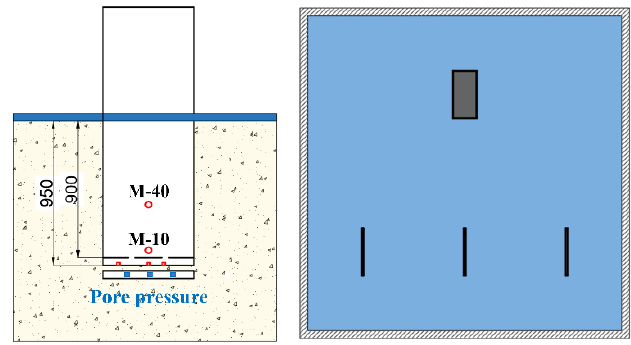
Figure 7. Schematic diagram of the BB25 model and sensor arrangement.